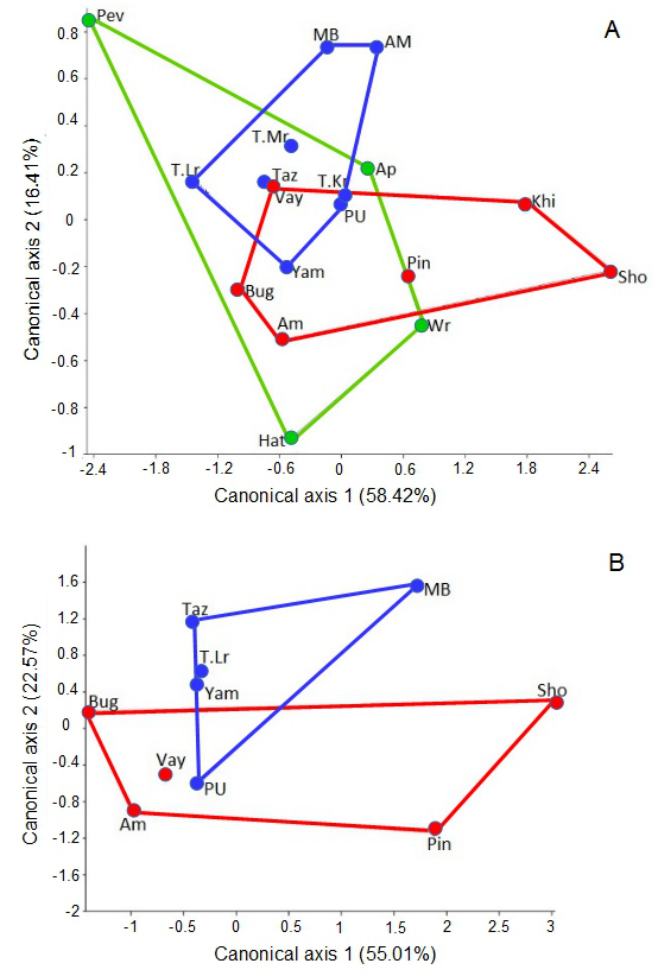
Figure 4. Plot of the population centroids onto the first two canonical axes for the pronotum ( A ) and the aedeagus ( B ) shape of Pterostichus brevicornis brevicornis (for population abbreviations see Supplementary Materials Table S3). Spot and polygon colours: red—North Europe; blue—West and Central Siberia; green—Northeast Asia.